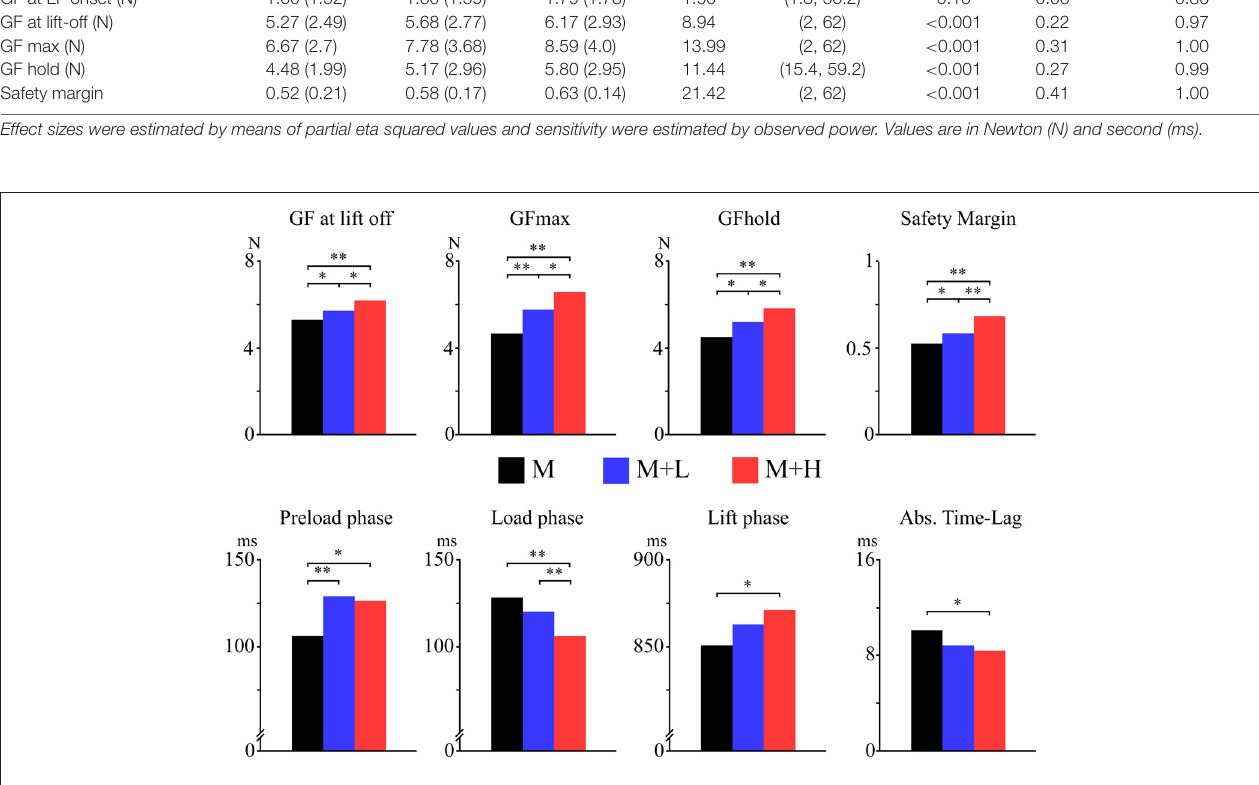
duration of the Load phase ( F ( 1.7,44.8 ) = 13.68; p < 0.001), and